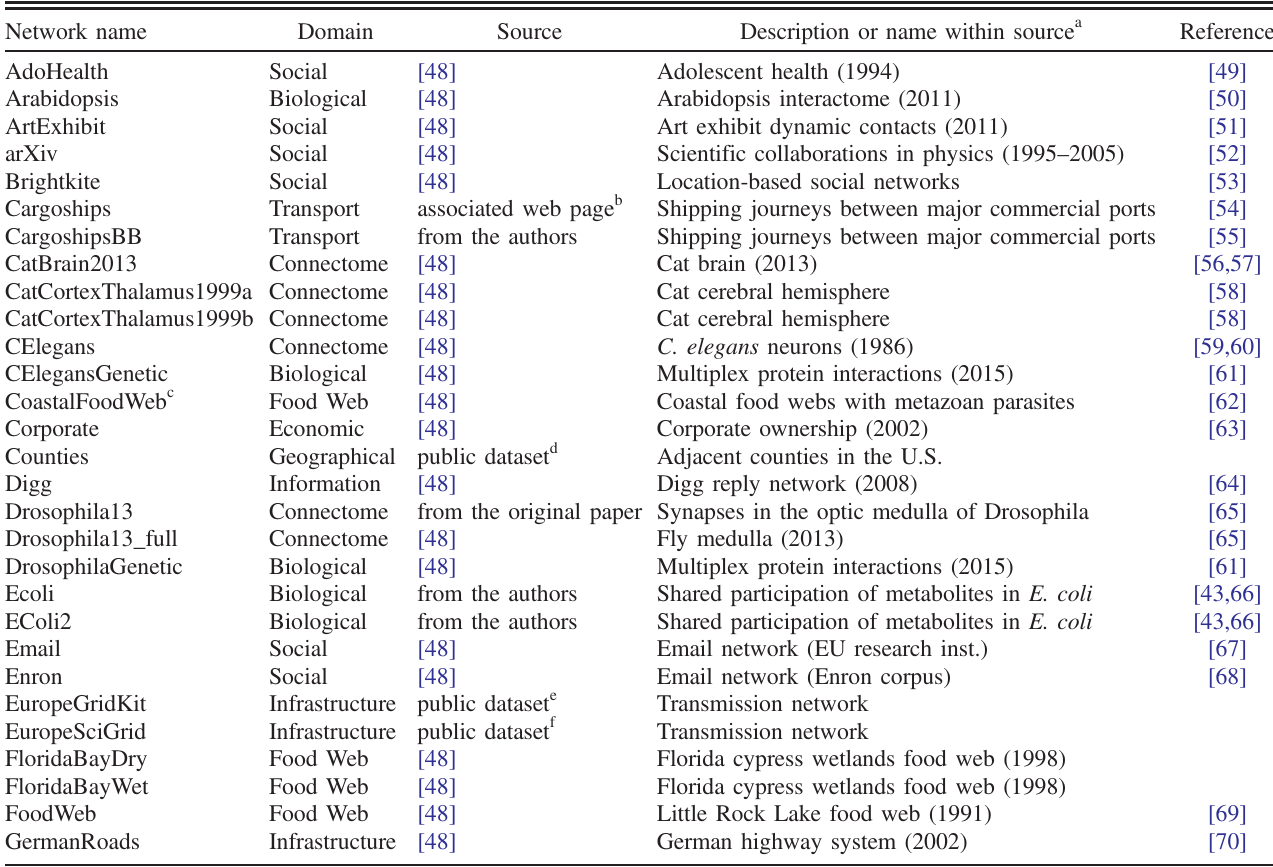
TABLE I. Description of the network